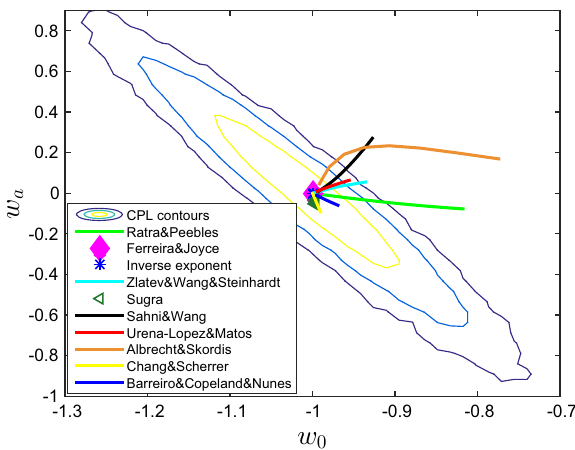
Fig. 2 Similar to the Fig. 1, for the phantom models